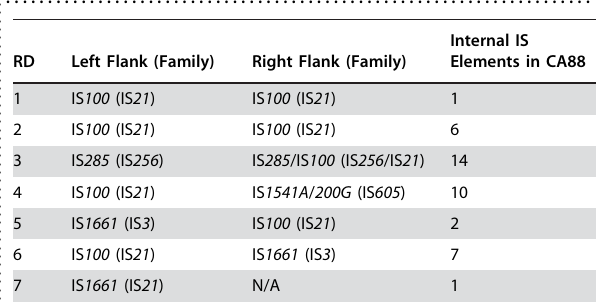
Table 2. IS element analysis of the seven large regions of